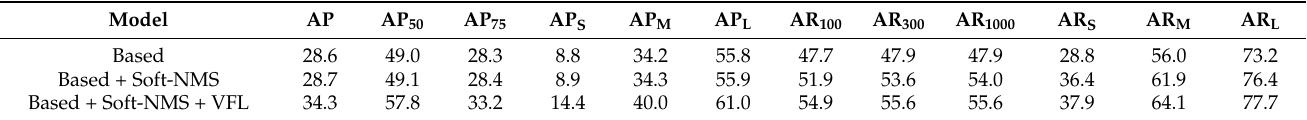
Table 9. Further Improved Methods Evaluation Results.